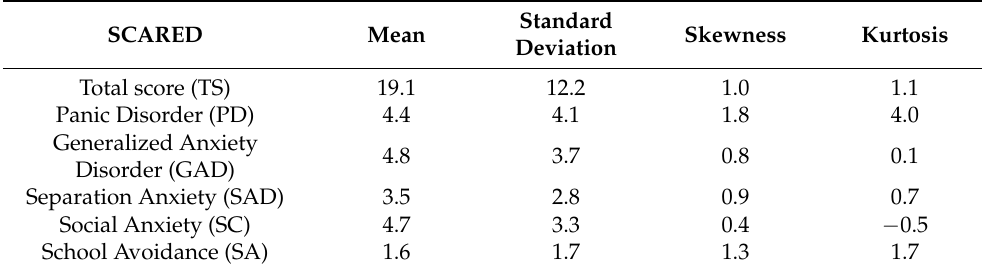
Table 1. Demographic means, standard deviations, and skewness and kurtosis of the anxiety sub-